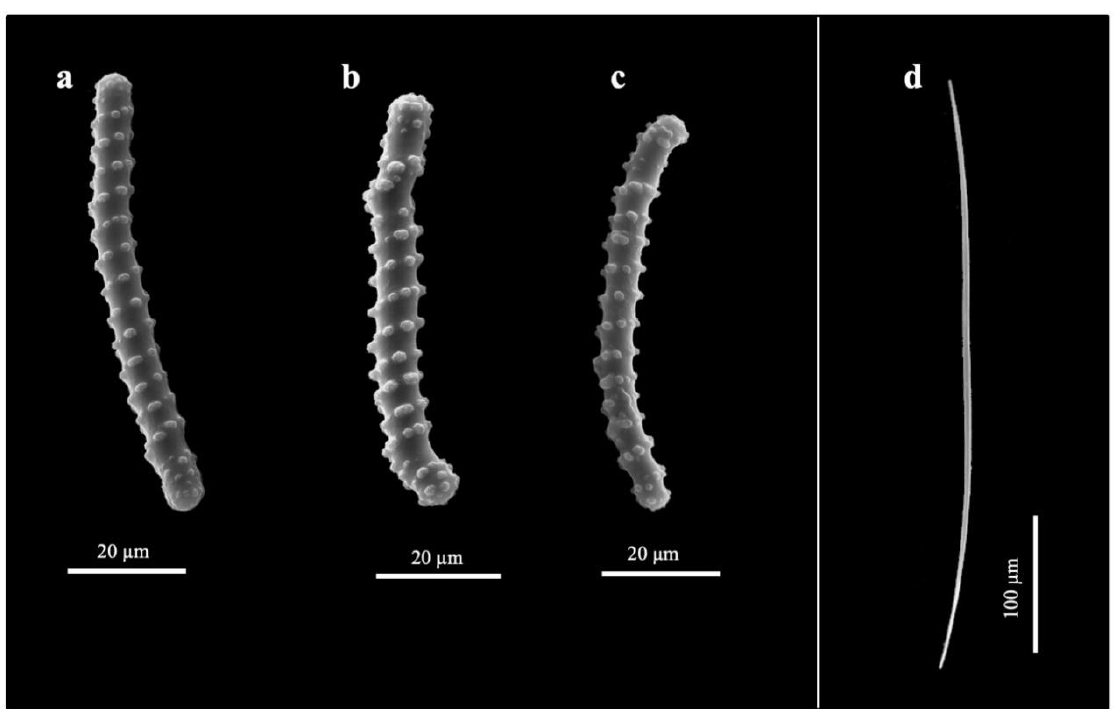
Figure 9. Spicule composition of Dotona pulchella mediterranea . SEM images: ( a – c ) microstrongyles with microspined tubercles, spirally arranged; ( d ) style.